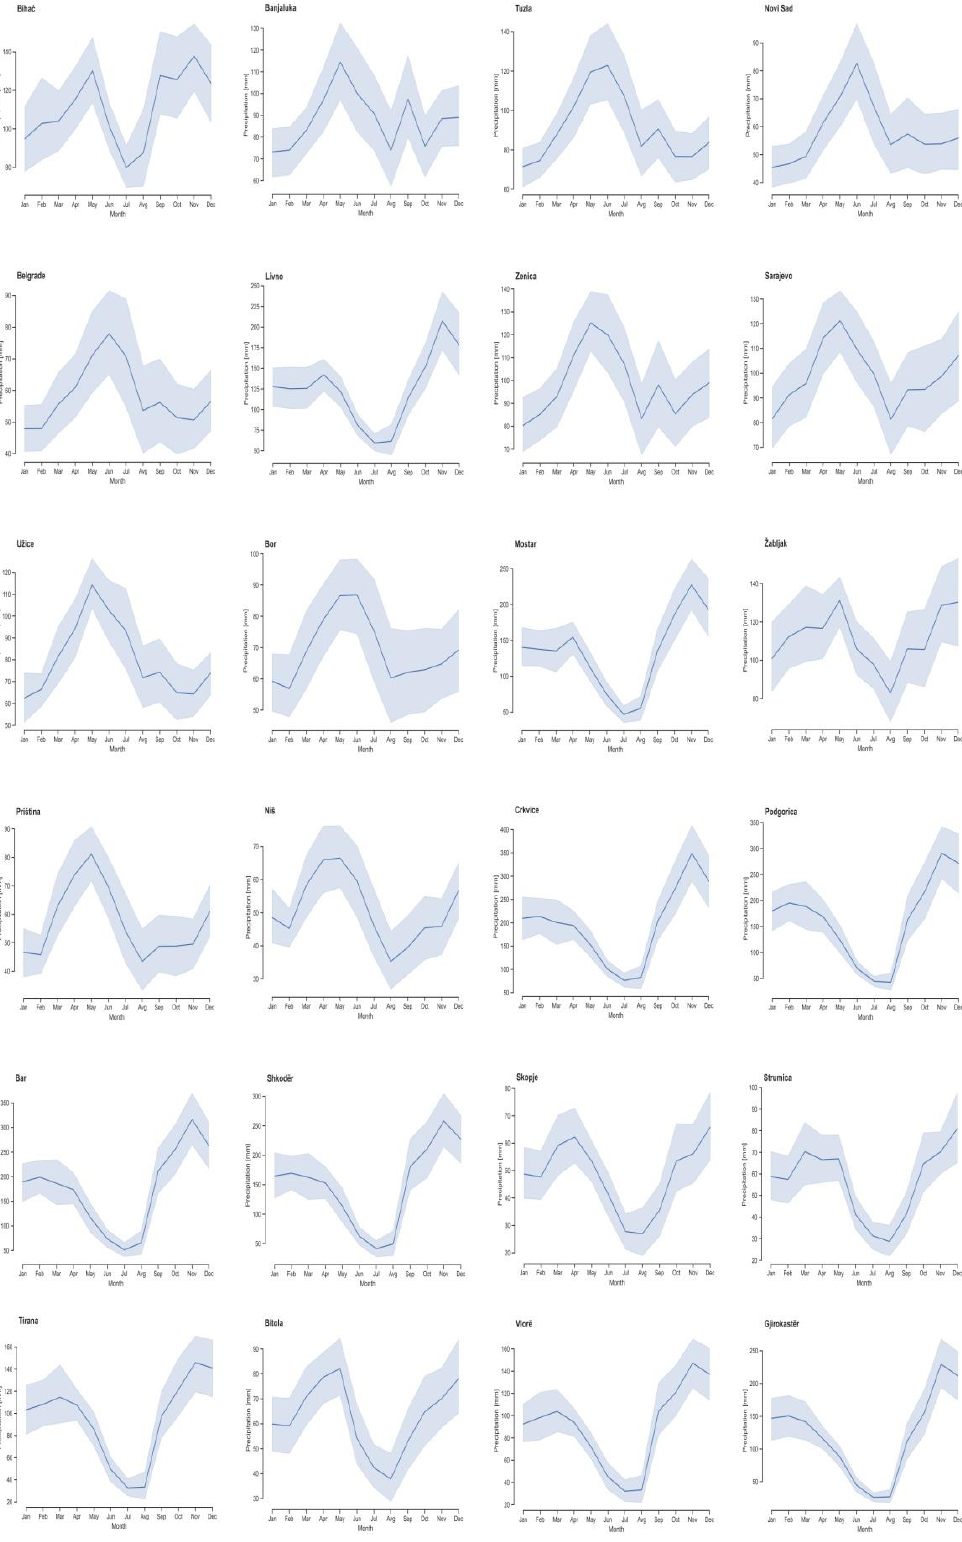
Figure 4. Intra-annual variations in monthly precipitation [mm] for the period 1991–2020 were obtained from the nearest ERA5 grid cell to the city (for more details see Figure A1). The shaded area represents the 95% confidence interval.